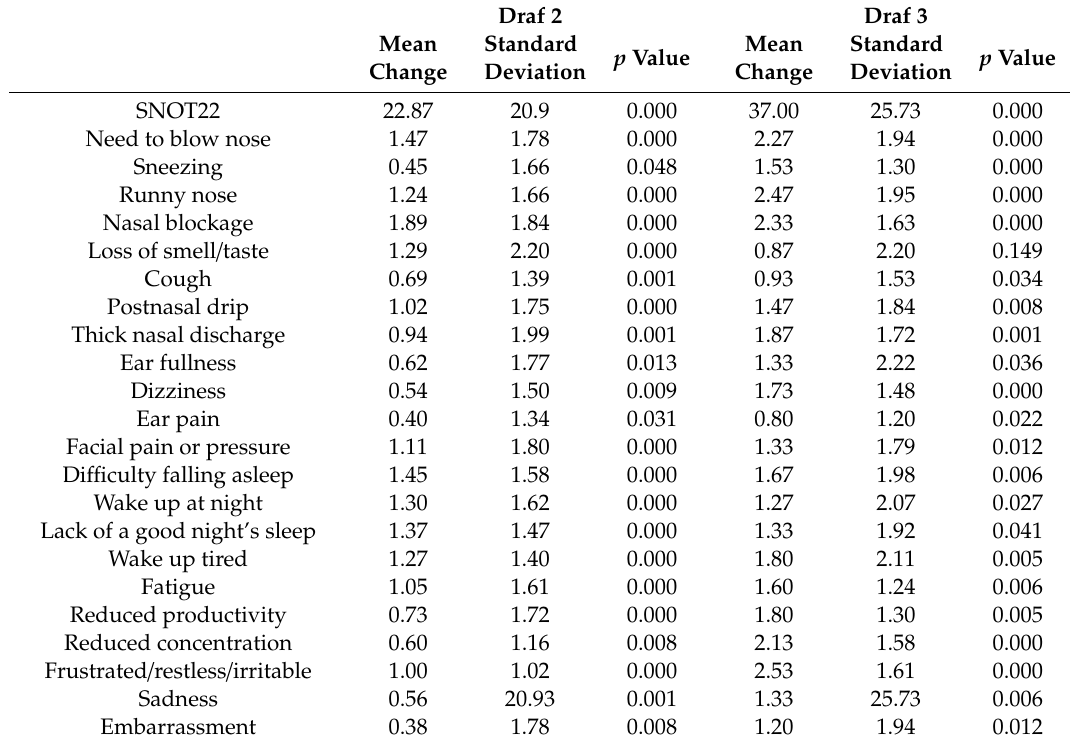
Table 3. Draf 2 / Draf 3 group-mean change in every SNOT-22 item at postoperative follow-up at 1–3 months.